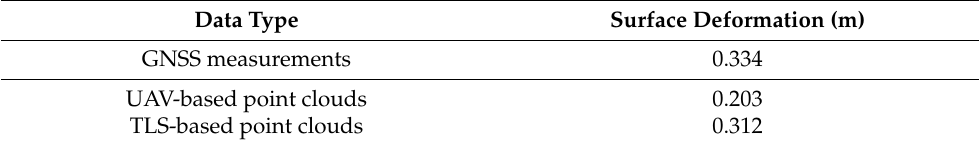
Table 2. Surface deformation on permanent GNSS pillar 2.